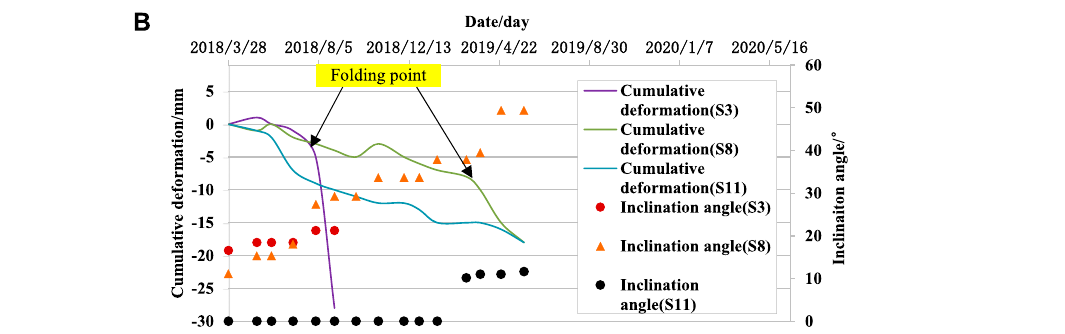
(Figure 13). The folding points of S3 and S10 appeared